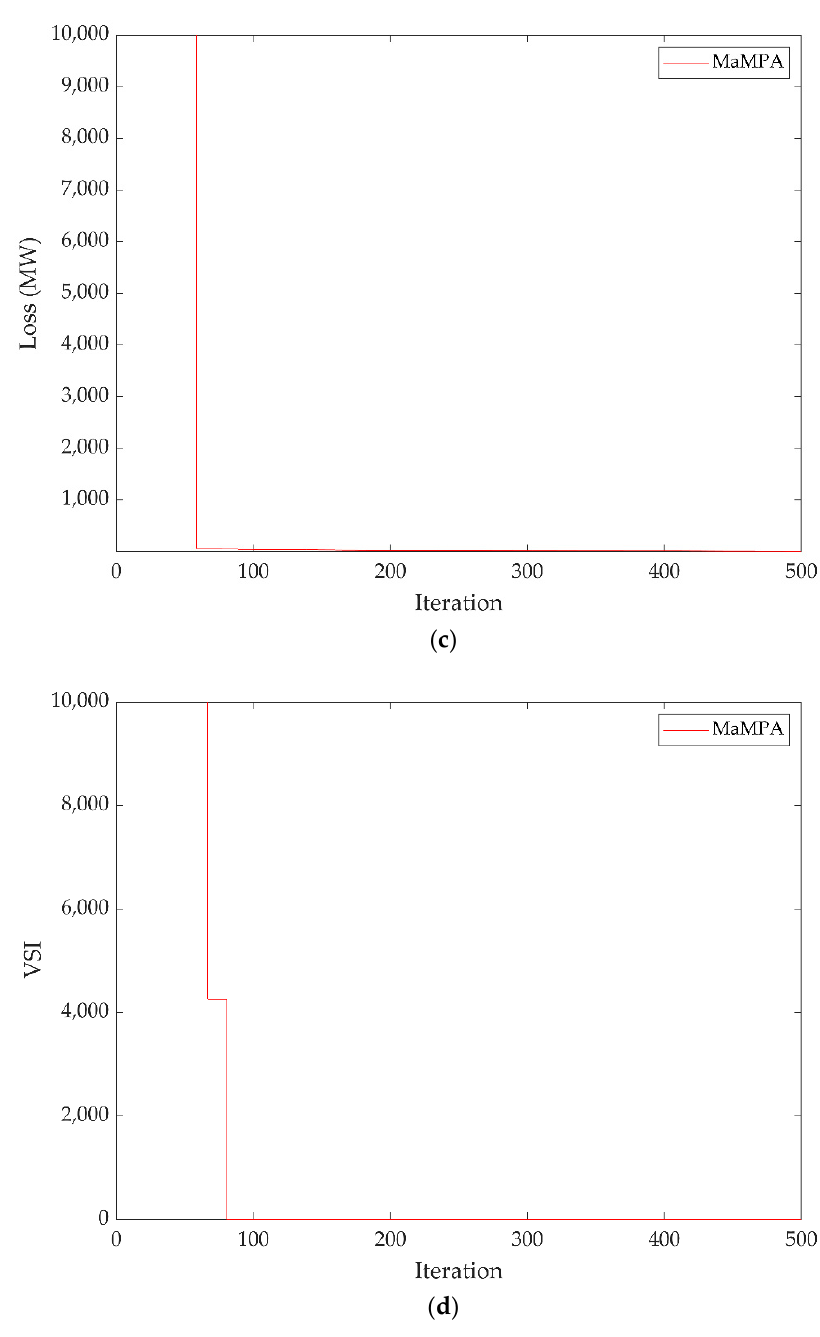
Figure 3. Convergence curves of MaMPA for: ( a ) case 5; ( b ) case 6; ( c ) case 7; ( d ) case 8.